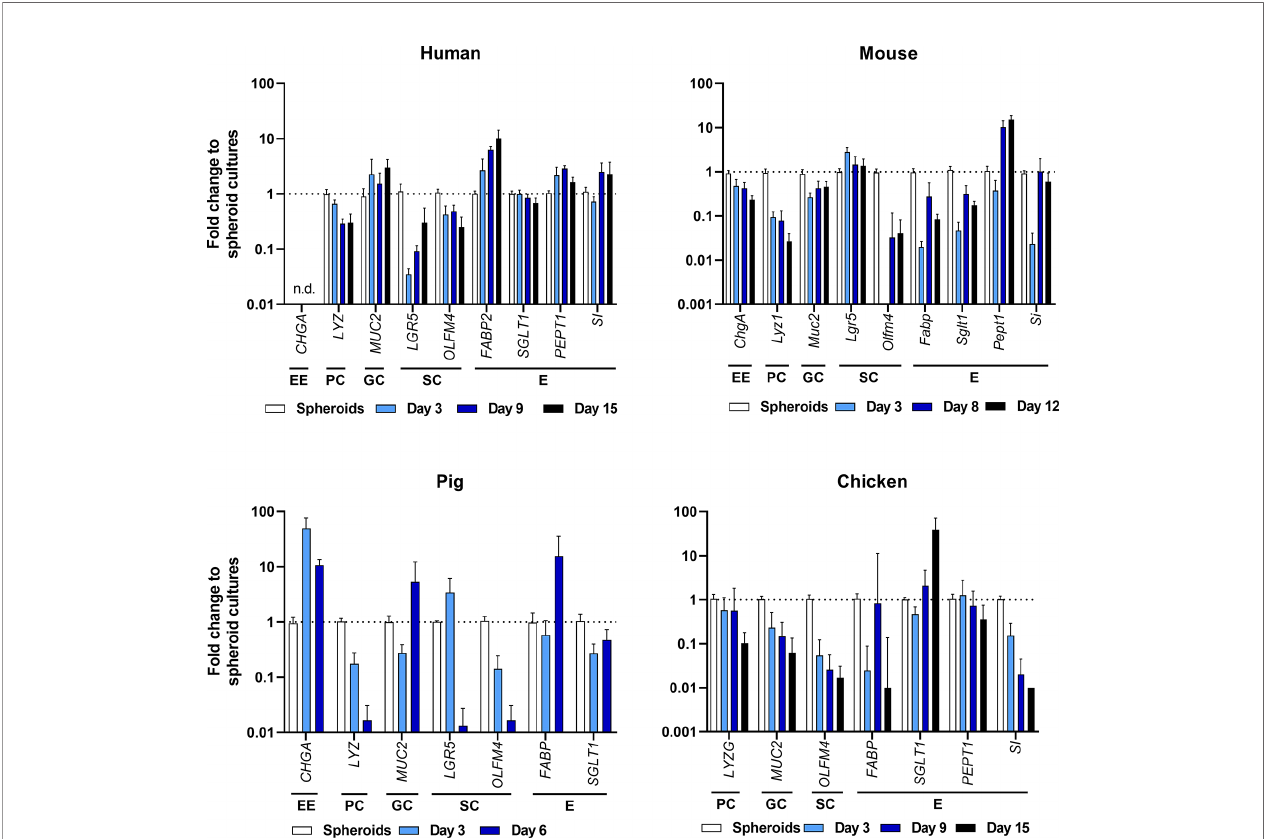
FIGURE 4 | Expression pro fi ling of intestinal cell types by RT-qPCR of ODMs from human, mouse, pig and chicken origin. Indicated markers represent EE, enteroendocrine cells; PC, Paneth cells; GC, goblet cells; SC, stem cells; and E, enterocytes. RT-qPCR experiments show mean (± 95% CI) of ≥ 4 technical replicas of at least two independent biological replicates. n.d., not